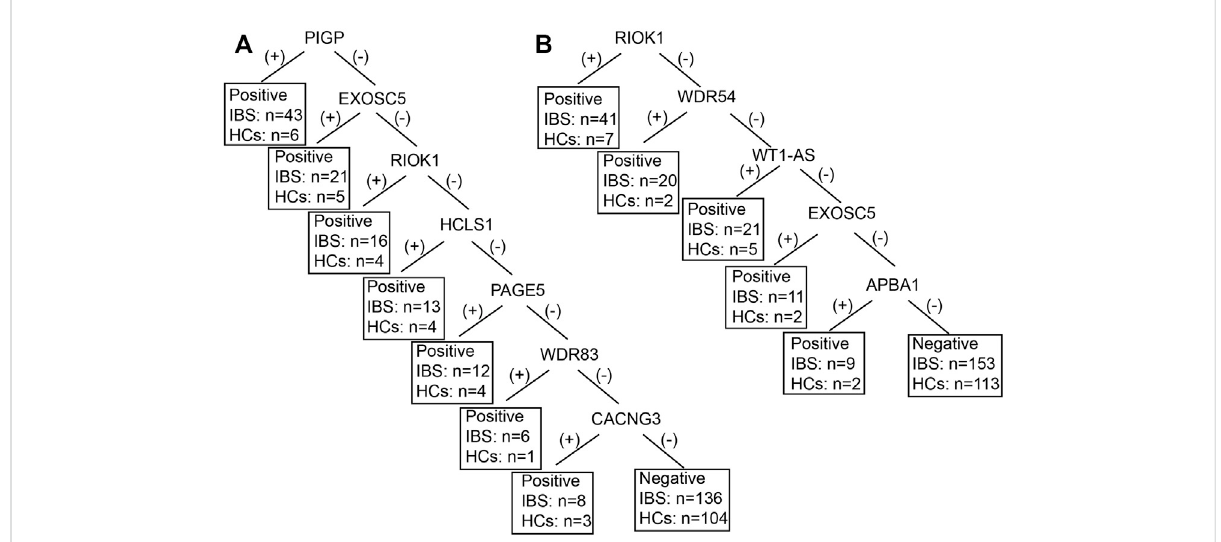
FIGURE 2 The decision tree model of IBS-associated autoantigens IgA (A) and IgG (B) between IBS patients and HCs. IBS, irritable bowel syndrome; HCs, healthycontrols.Forexample,in fi gureB,iftheRIOKwas(+),IBScanbediagnosed,41IBSwerediagnosedasIBS,7 HCswerediagnosedasIBS.Ifthe RIOKwas( − ),thenWDR54wastested.IftheWDR54was(+),IBScanbediagnosed,20IBSwerediagnosedasIBS,2 HCswerediagnosedasIBSandso forth. Positive refers to IBS can be diagnosed. Negative refers to healthy control can be diagnosed.